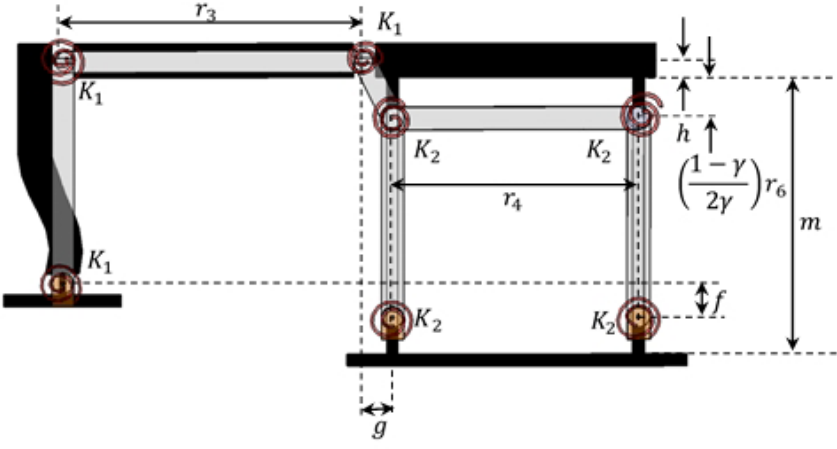
Figure 9. Fully compliant slider-crank mechanism overlapped with its PRBM. Table 1. Design table of the fully compliant slider-crank mechanisms.